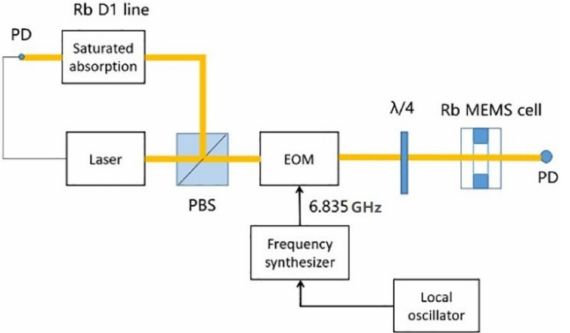
Figure 5. Schematic of the table-top CPT system with MEMS cell. EOM: electro-optic modulator. PD: